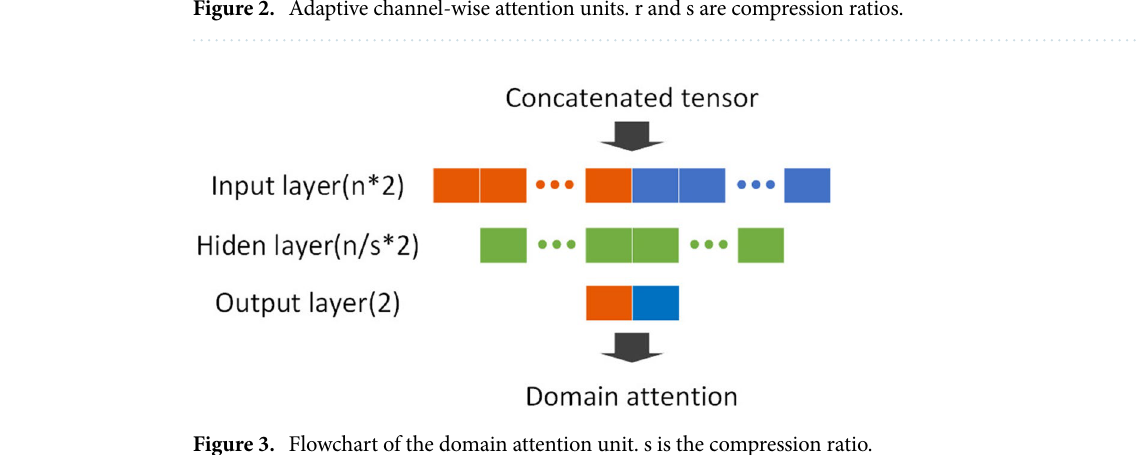
Figure 3. Flowchart of the domain attention unit. s is the compression